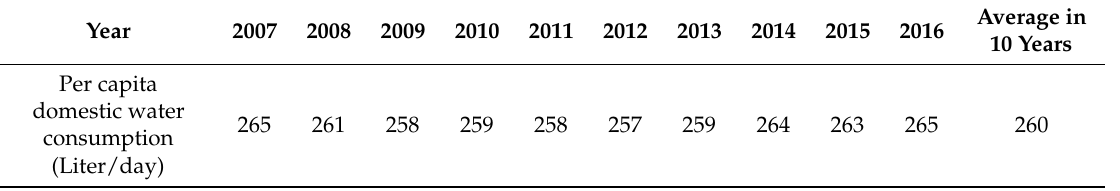
Table 1. Average daily per capita domestic water consumption in Taiwan